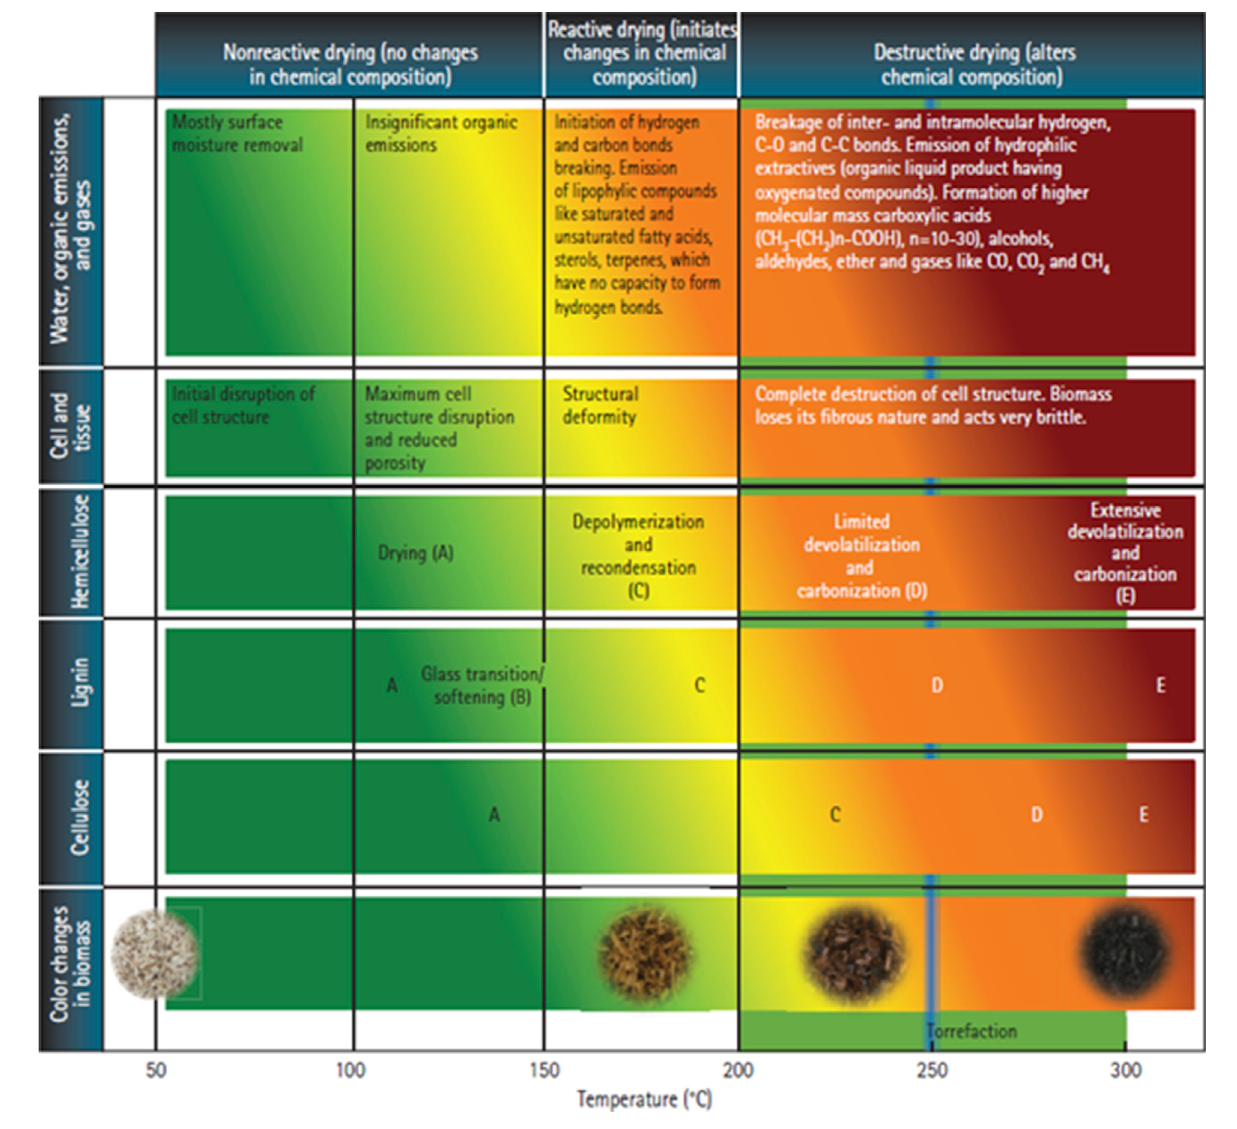
Frontiers in Energy Research |